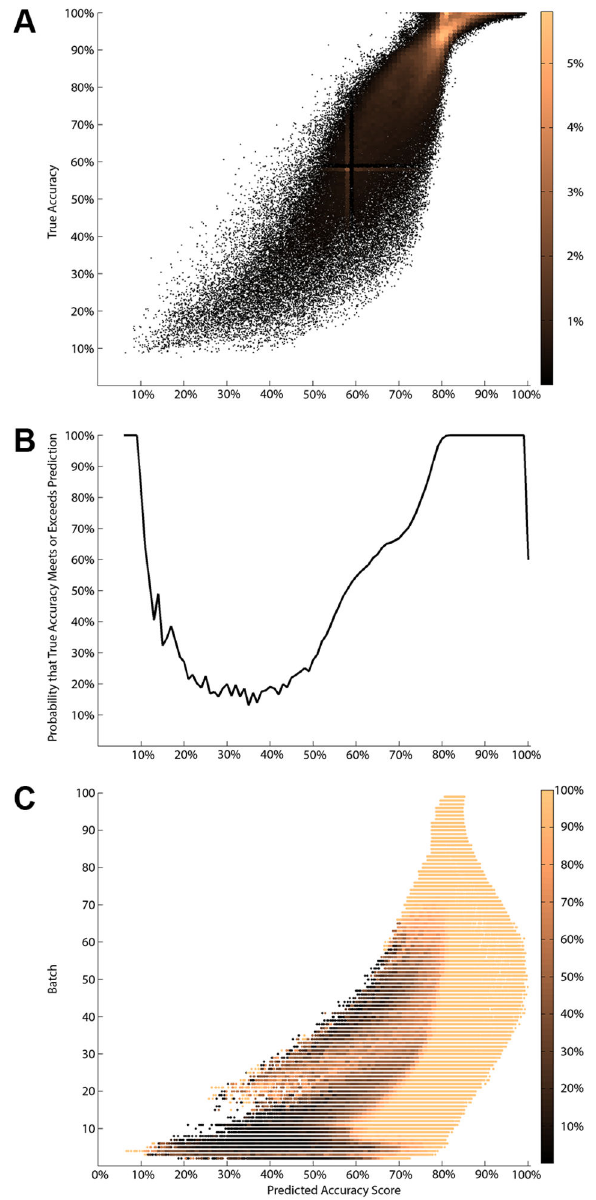
Figure 5. Probability of approximate correctness over a broad range of data. (A) The empirical density of the correspondence between the predicted accuracy score and the true (latent) accuracy; lighter colors indicate greater frequency. (B) Confidence (in units of probability) per level set of predicted accuracy score. (C) Per-batch and (1% binned) predicted accuracy score confidences; color indicates confidence (in units of probability).